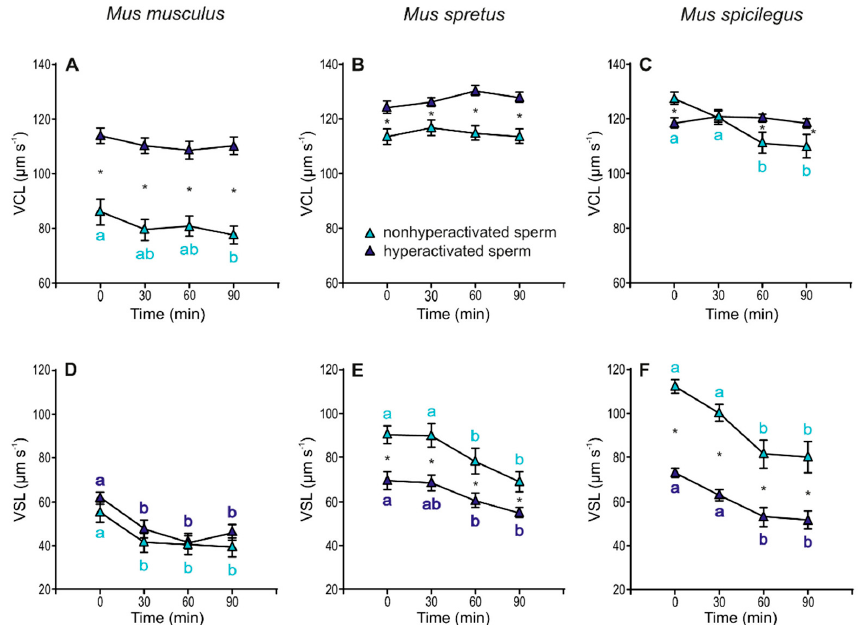
Figure 8. Variation in velocity descriptors (VCL and VSL) in hyperactivated and non-hyperactivated spermatozoa from three mouse species ( M. musculus , M. spretus , M. spicilegus ) under capacitating conditions (mT-BH medium under 5% CO 2 /air). Data are means ± SE ( n = 7 in M. musculus , n = 8 in M. spretus , and n = 6 in M. spicilegus ). Light blue triangles: non-hyperactivated sperm in capacitating conditions. Dark blue triangles: hyperactivated sperm in capacitating conditions. ( A – C ) Curvilinear velocity (VCL) (µm s − 1 ), ( D – F ) Straight-line velocity (VSL) (µm s − 1 ). ( A , D ) M. musculus . ( B , E ) M. spretus . ( C , F ) M. spicilegus . Asterisks indicate significant differences ( p < 0.05) between non-hyperactivated and hyperactivated sperm for the same time in a Fisher post-hoc test. Different letters between times of incubation for the same status (hyperactivated or non-hyperactivated) indicate statistically significant differences ( p < 0.05) in a Fisher post-hoc test. If two time-points of an incubation share any letter, the differences between them are not significant. No letters were used when a time-point of an incubation did not show any significant effect in the dependent variable. Table 3. Effect of time of incubation (“Time”), sperm status (“Status”: hyperactivated vs. non-hyperactivated), and interactions between time and status (“Interaction”) on kinetic parameters in three mouse species ( M. musculus , M., spretus , and M. spicilegus ) incubated under capacitating con- ditions (mT-BH medium). Values F and p correspond to statistical analyses of repeated measure ANOVAs. Individual was used as a random factor, and incubation conditions and time were used as fixed factors. Results in bold indicate significant differences ( p < 0.05) in statistical analyses. VCL: curvilinear velocity; VSL: straight-line velocity; LIN: linearity; ALH: amplitude of lateral head dis- placement; BCF: beat-cross frequency. Dependent Variable Independent Variable